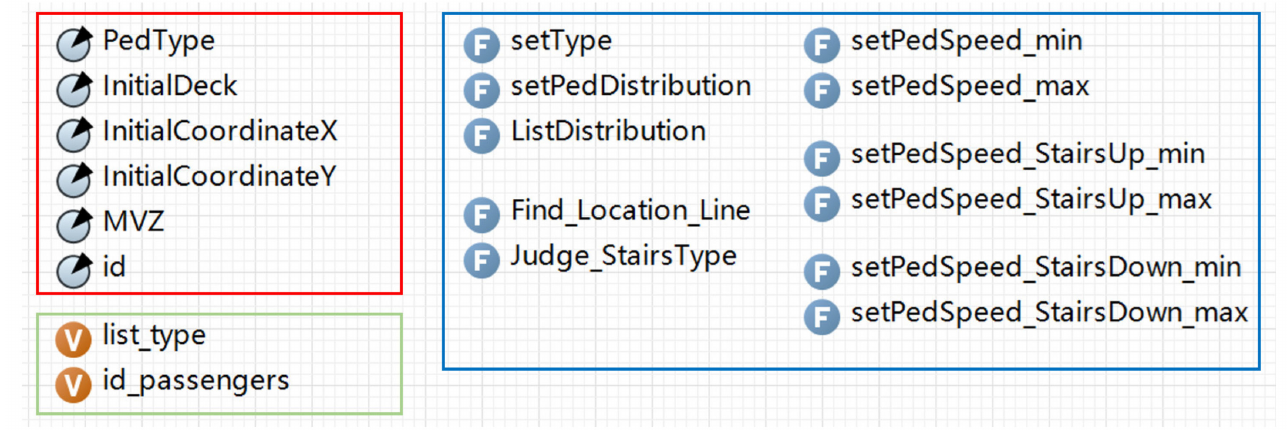
Figure 8. The passenger